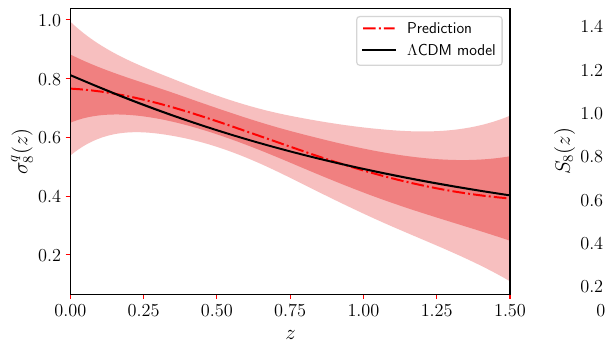
( z ) (the letter q to as in left panel, but for the S 8 ( z ) function. The black line represents 8 the prediction from the (cid:4) CDM model considering the Planck-CMB cosmological